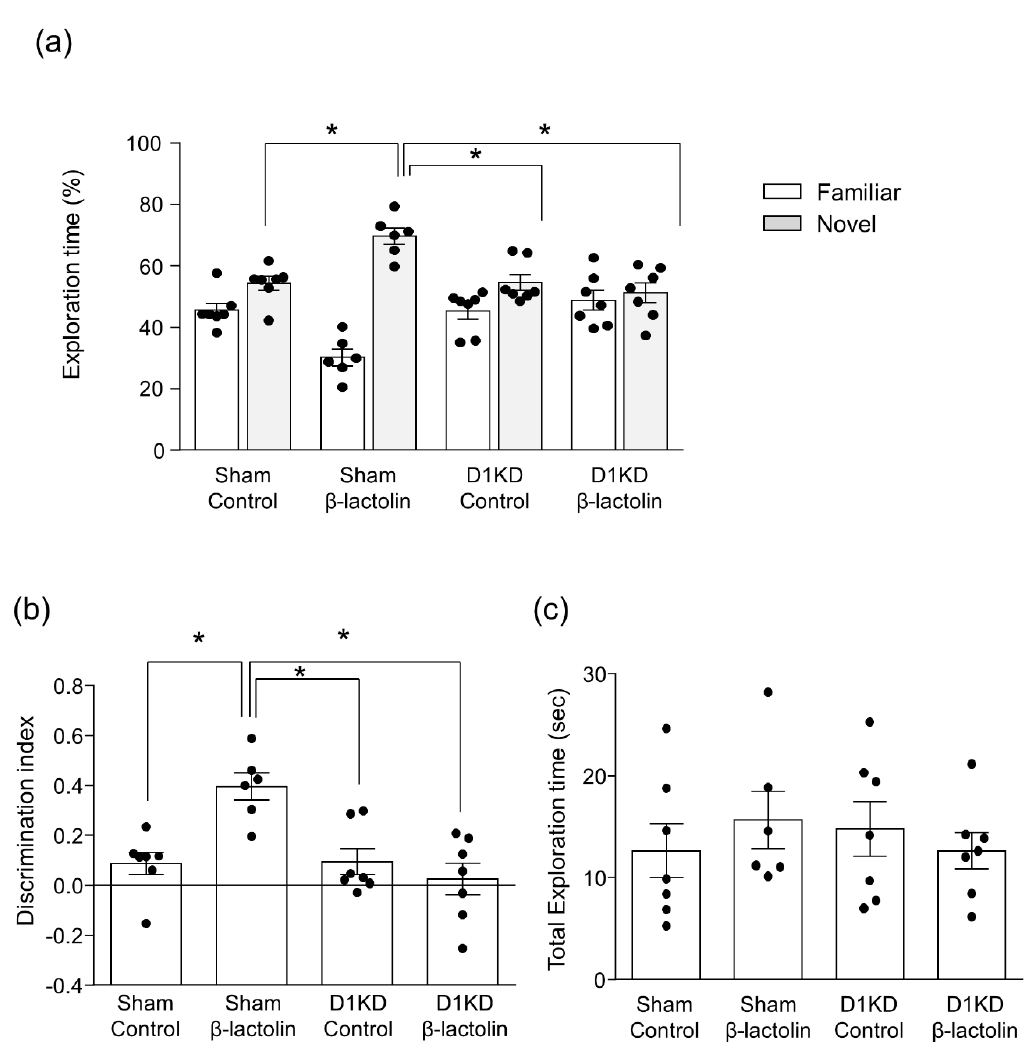
Figure 4. Knockdown of dopamine D1 receptor in the hippocampus abolished the effect of β -lactolin on spatial reference memory in the NOLT. Hippocampal DA D1 receptor knockdown mice or control-knockdown mice were orally administered β -lactolin (0 or 1 mg/kg), 60 min before the acquisition and recall periods. The time spent exploring the novel and familiar locations during the recall period was measured ( a ). The discrimination index was calculated using the following formula: (novel location exploration time - familiar location exploration time)/(total exploration time) ( b ). The total time spent exploring both locations was calculated ( c ). Results are presented as the mean ± SEM ( n = 6–7 mice per group). * p < 0.05 versus each group.